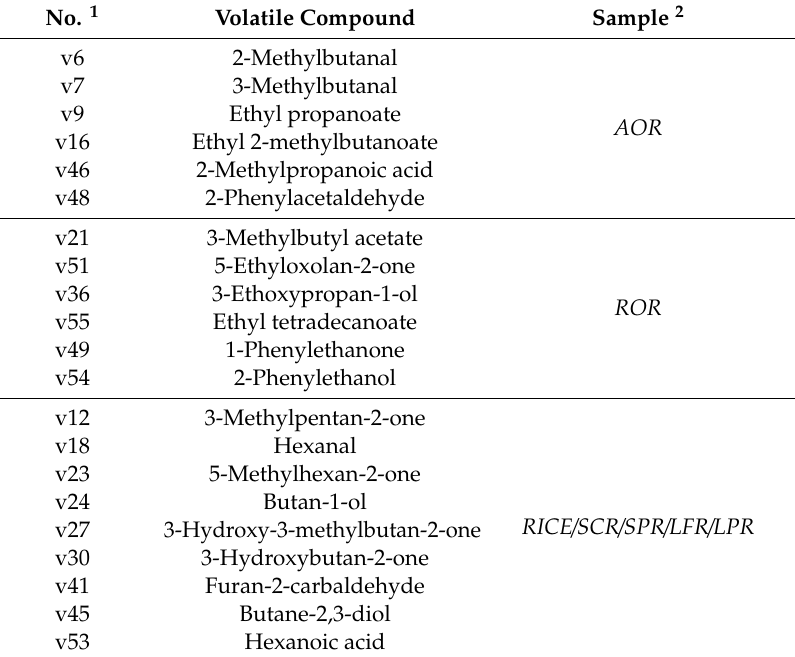
Table 1. Discriminant volatile compounds of di ff erent